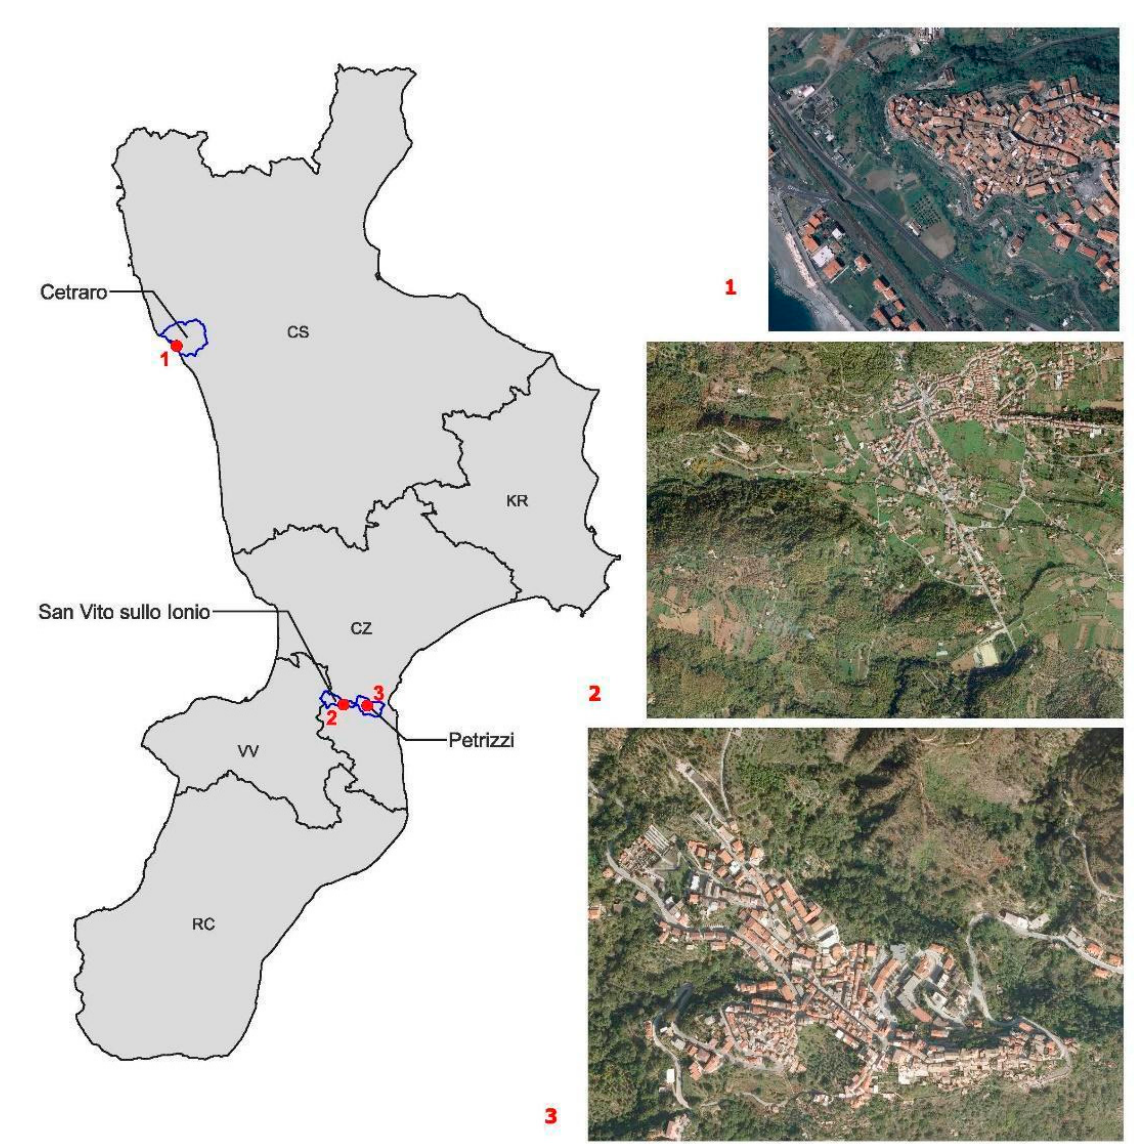
Figure 2. Study area framework.